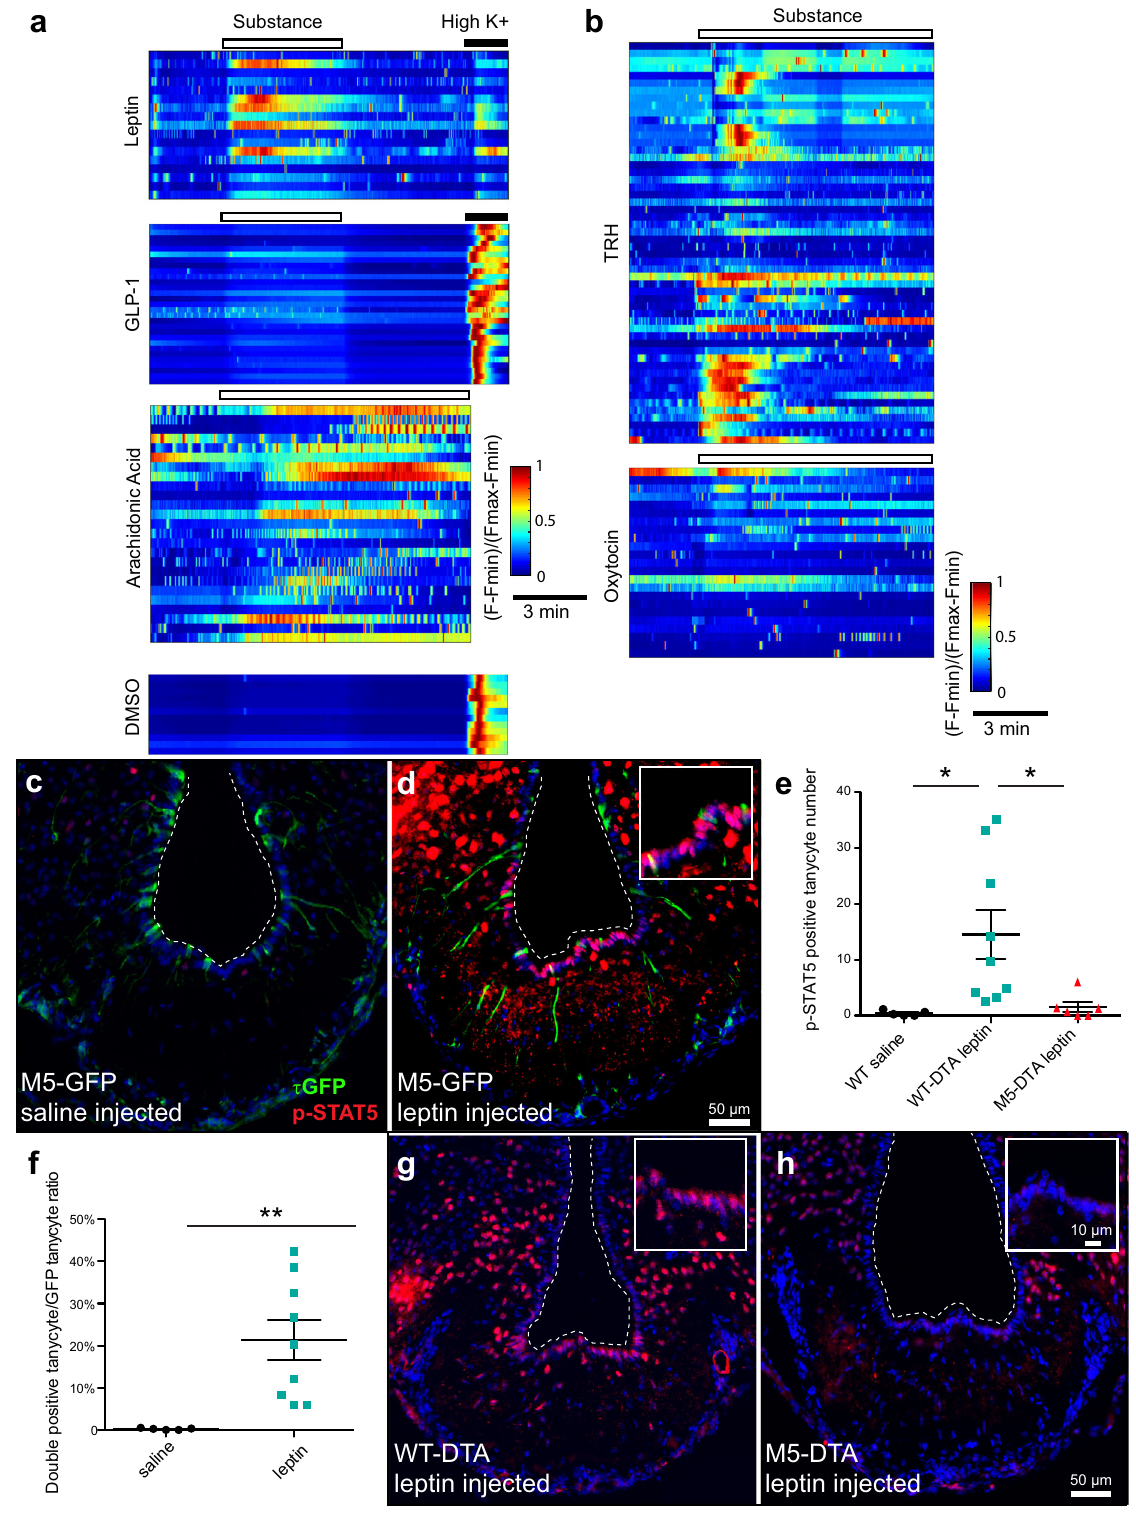
substances using functional imaging. In a heterologous cell culture expression setup, Tas2r113 could be activated with phenylbutazone, a synthetic drug